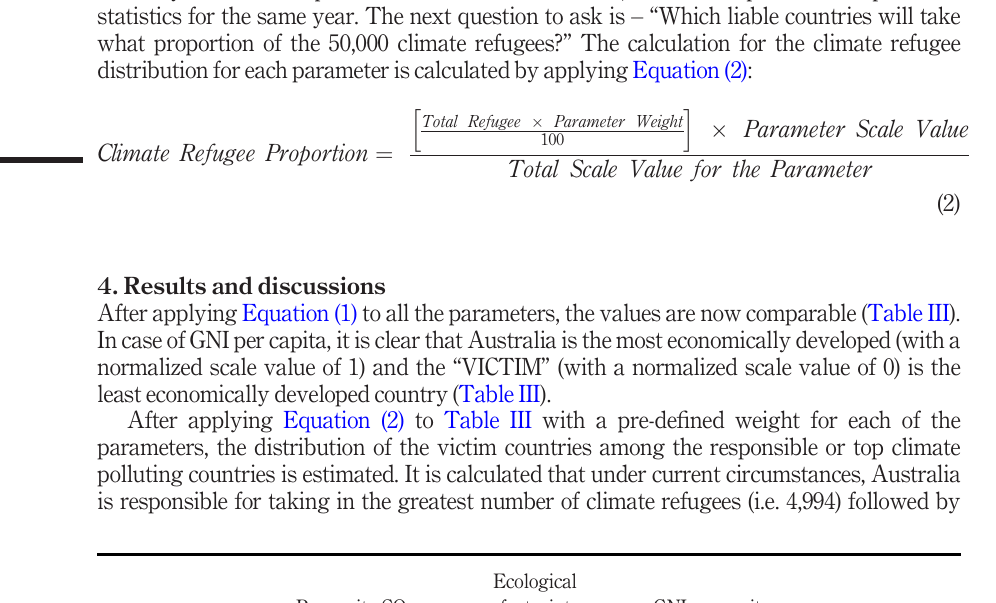
Top climate polluting